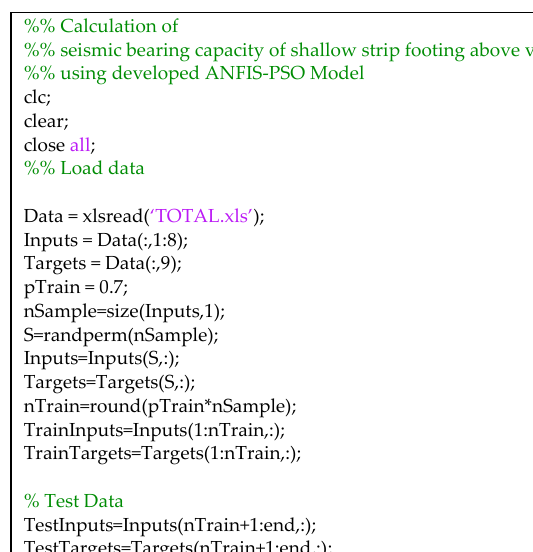
Table A4. MATLAB code for the adopted ANFIS-PSO model.